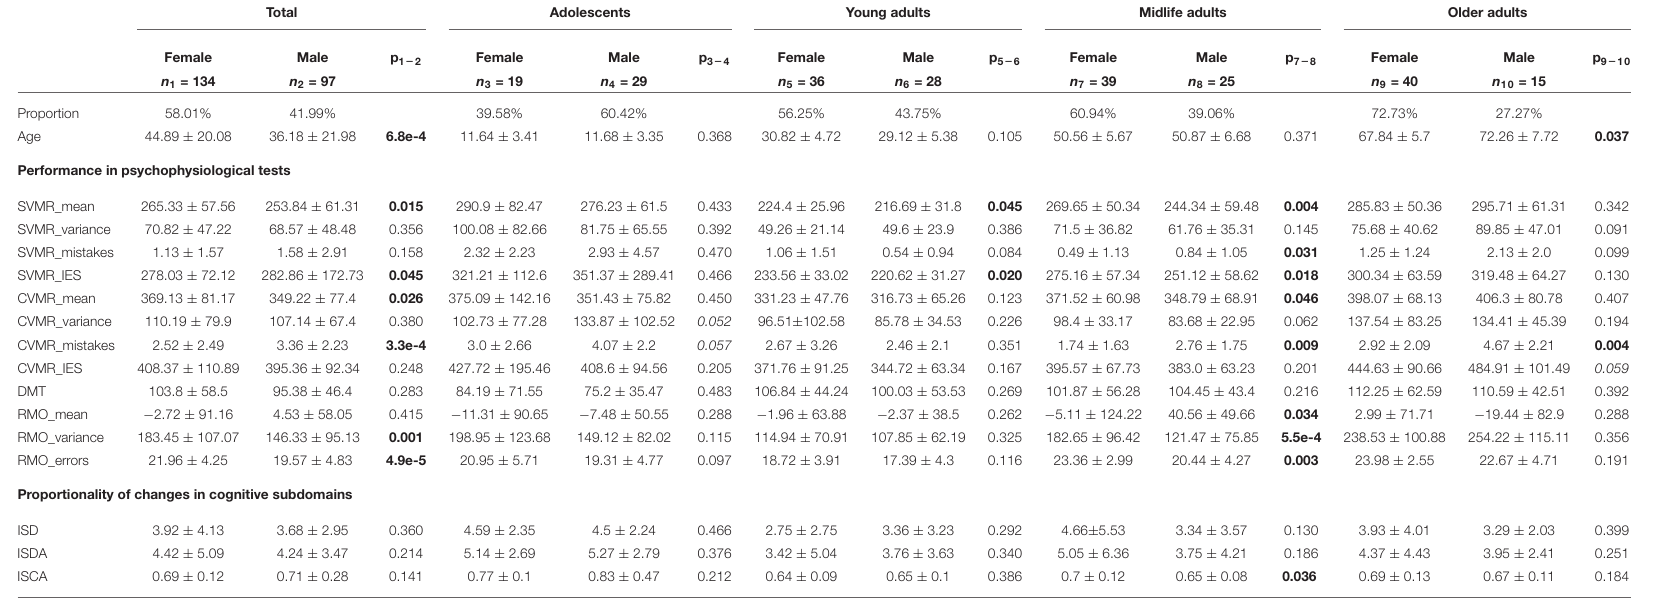
TABLE 4 | Performance in PTs with regard to sex and